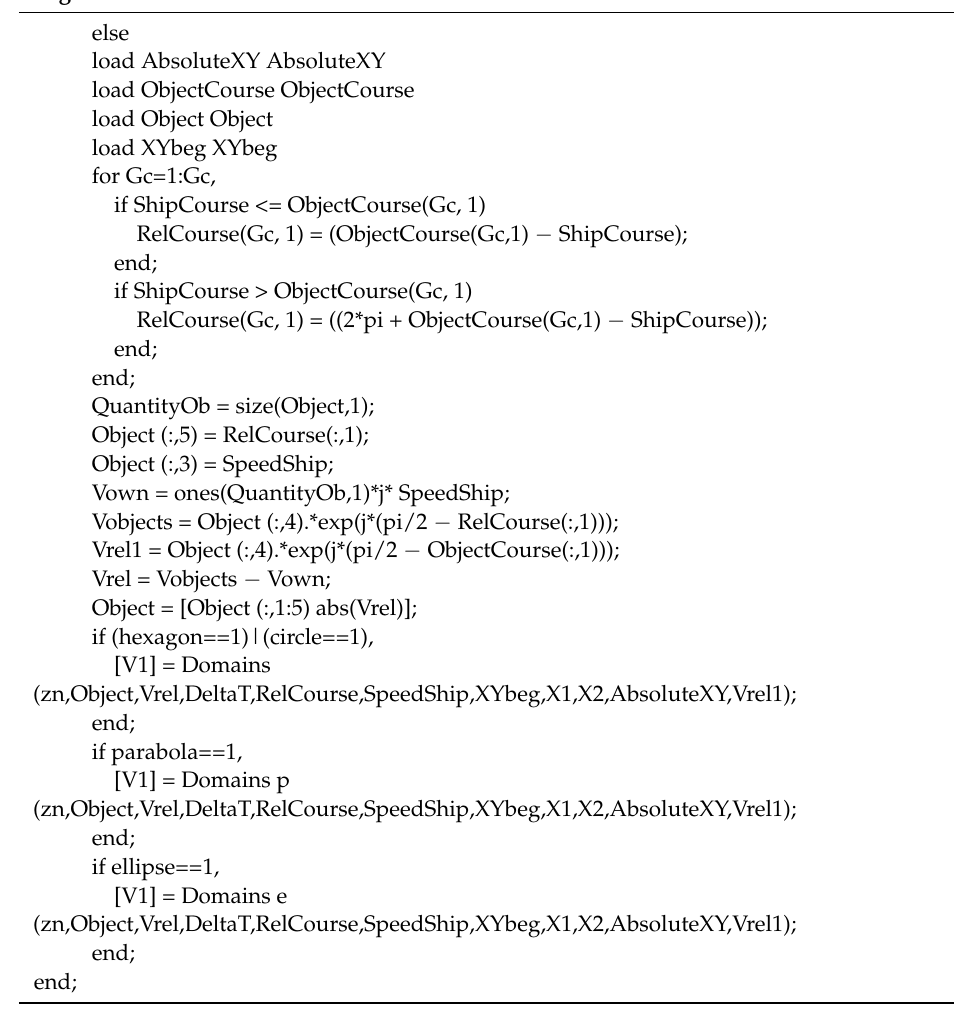
Algorithm 1: Neural Domains